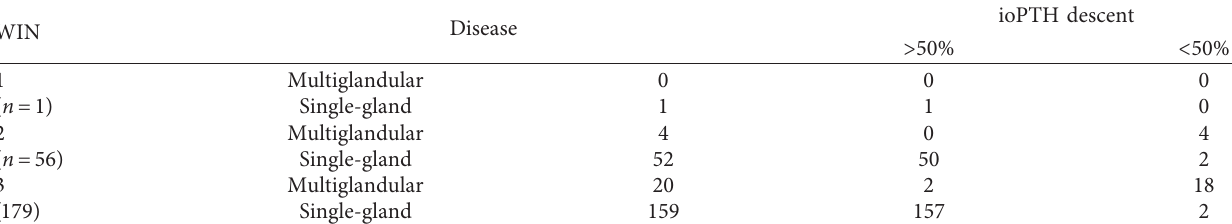
Table 11: Win score and ioPTH after excision of a single gland.